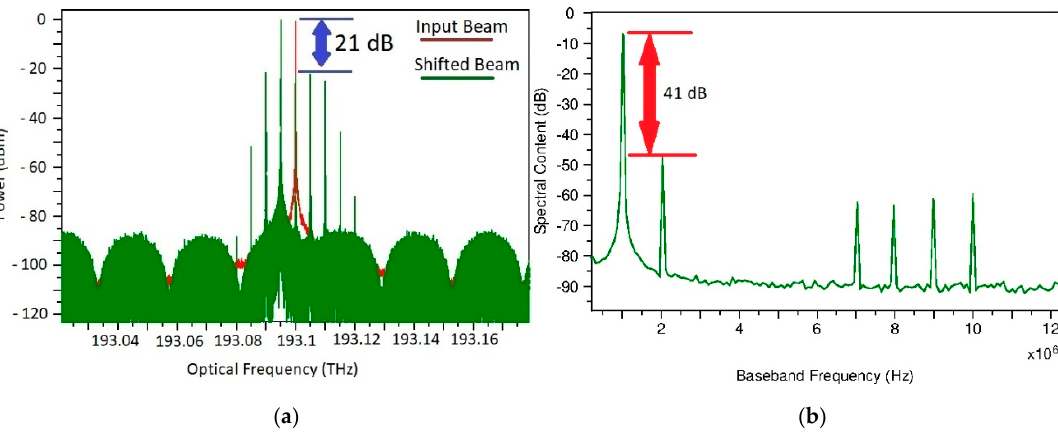
Figure 7. Normalized power spectra. ( a ) Resulting optical signal after a frequency shift. ( b ) IF signal after photodetection.